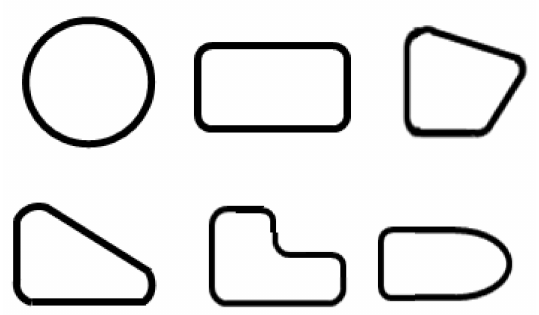
Figure 3. Examples of tube cross-section for 3DQ.